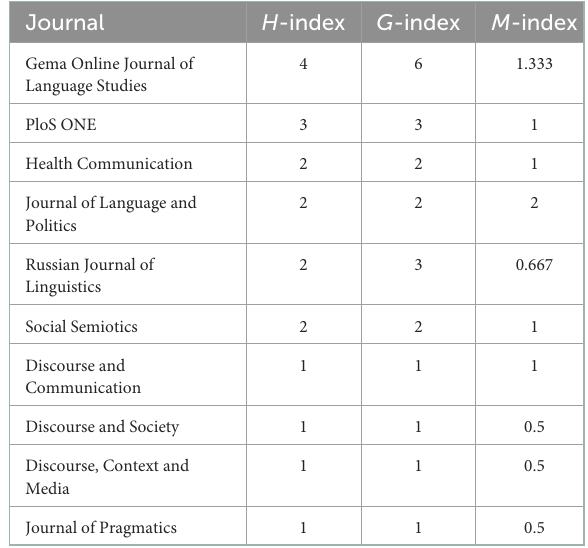
TABLE 1 Most productive authors of metaphor research during COVID-19.